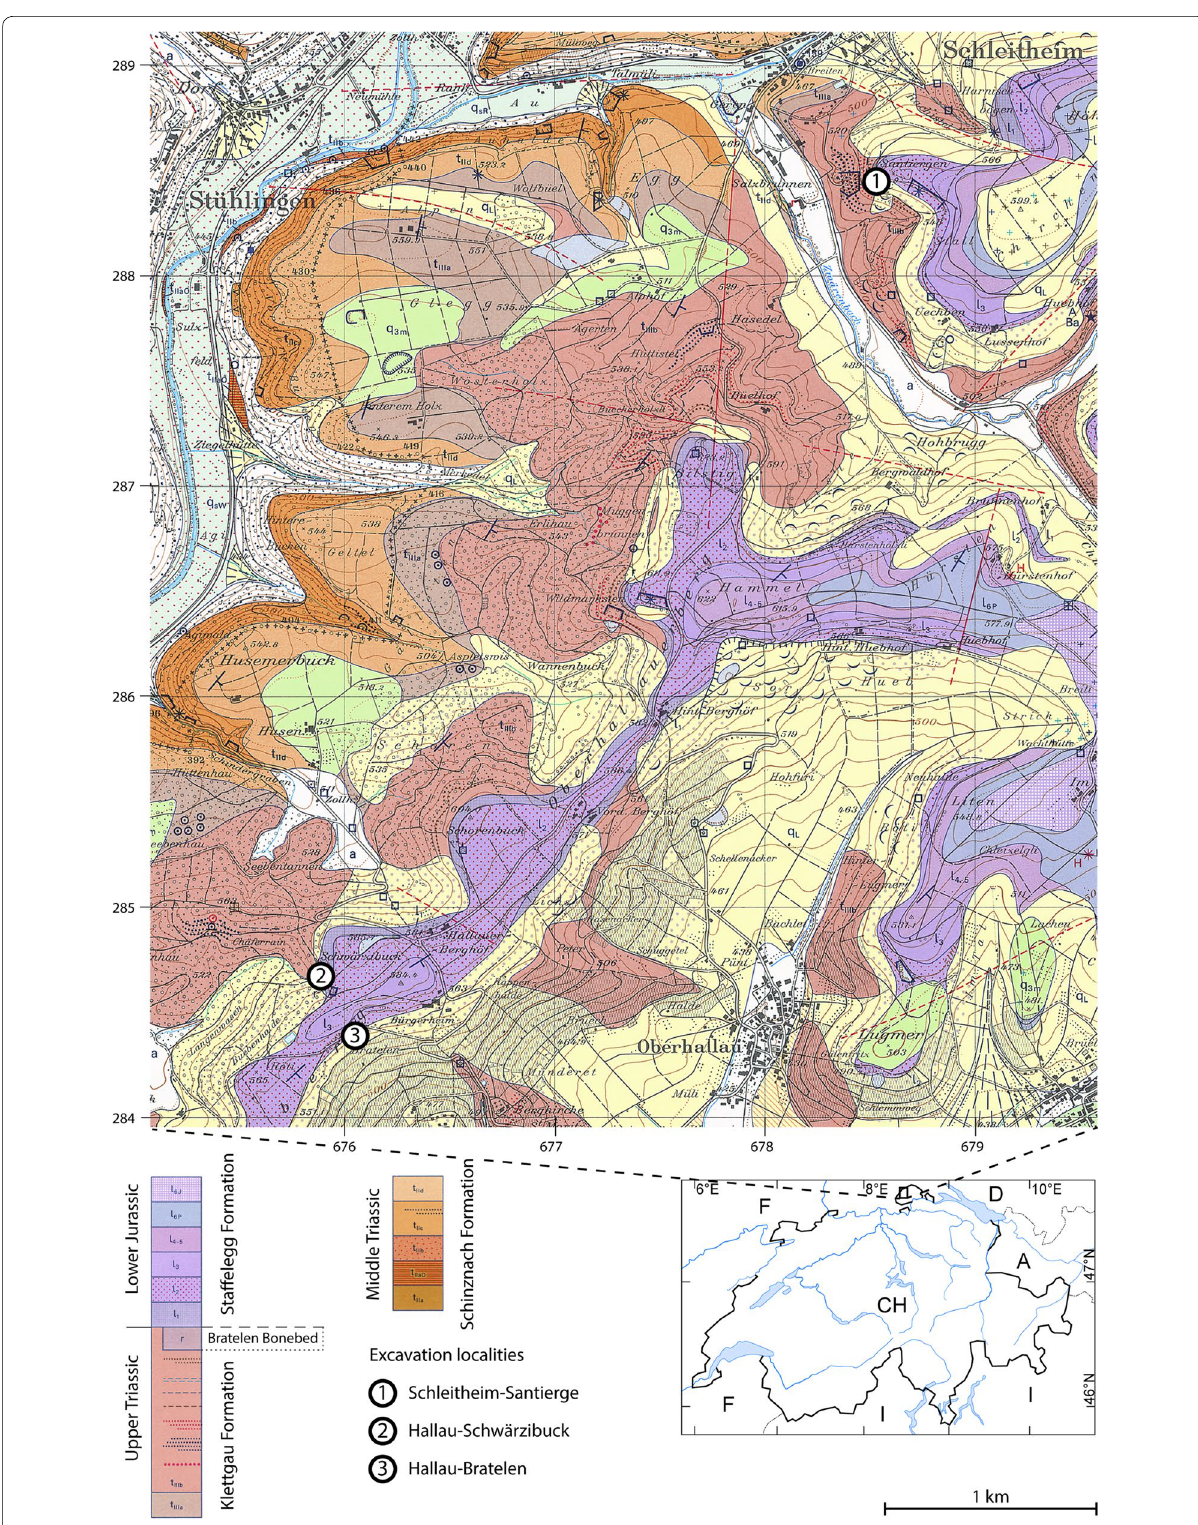
Fig. 1 Geological map with the localities Schleitheim-Santierge, Hallau-Bratelen and Hallau-Schwärzibuck in the western part of Canton Schaffhausen, Switzerland (license for reproduction of the geological map by swisstopo, December 11,